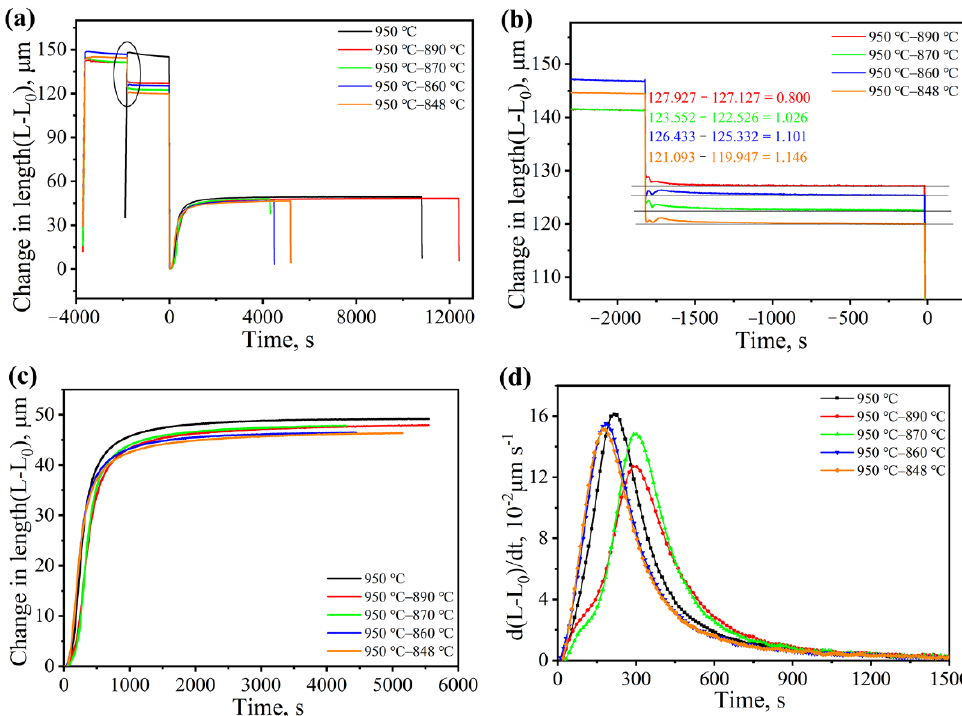
Figure 5. ( a ) Time – expansion curves at different temperatures; ( b ) changes in expansion amount under different processes; ( c ) isothermal curves of different processes; and ( d ) bainite transformation rates under different heat treatment process.